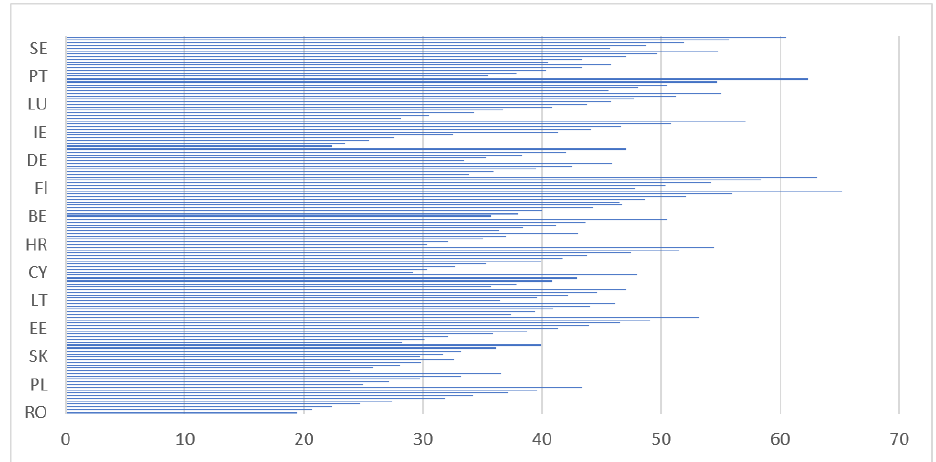
Figure 4. The DESI composite index in selected EU